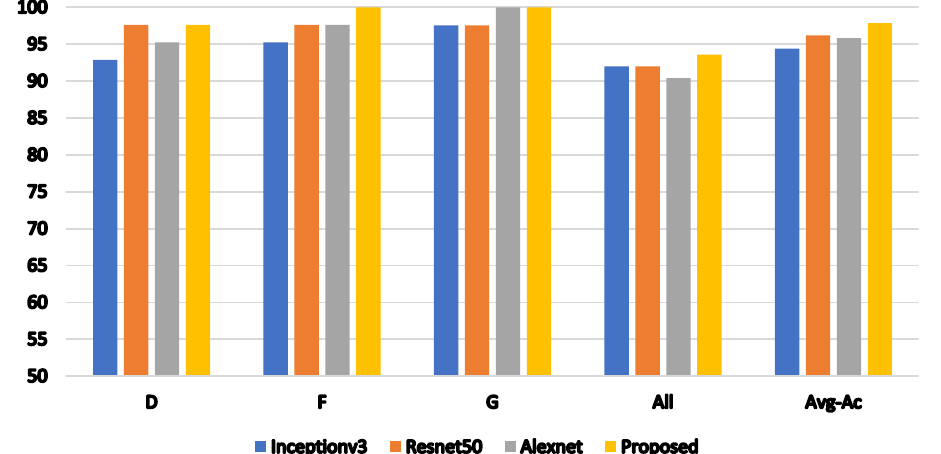
Figure 2. The accuracy comparison between CNNs models and the proposed one.